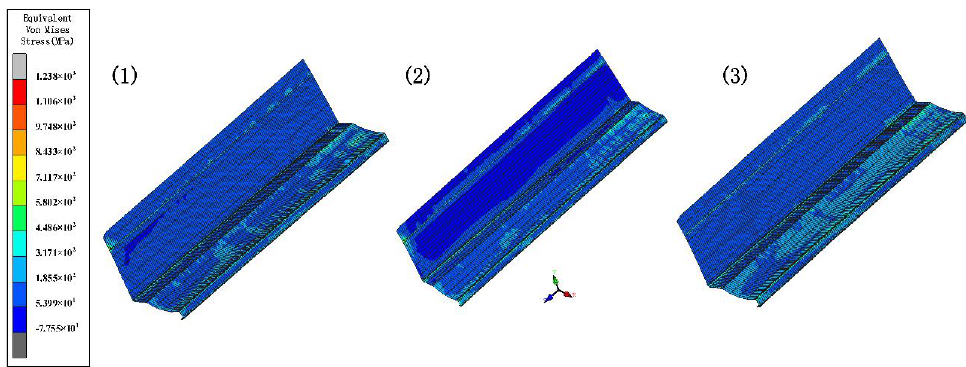
Figure 13. The variation in the equivalent von Mises stress distribution of strip under different friction levels.